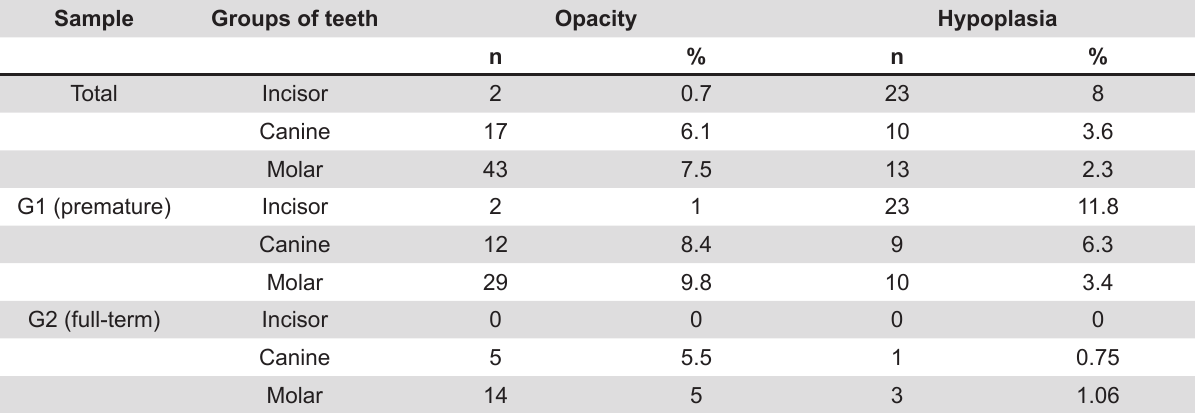
Table 2- Percentage of primary teeth with opacity and hypoplasia in G1 and G2